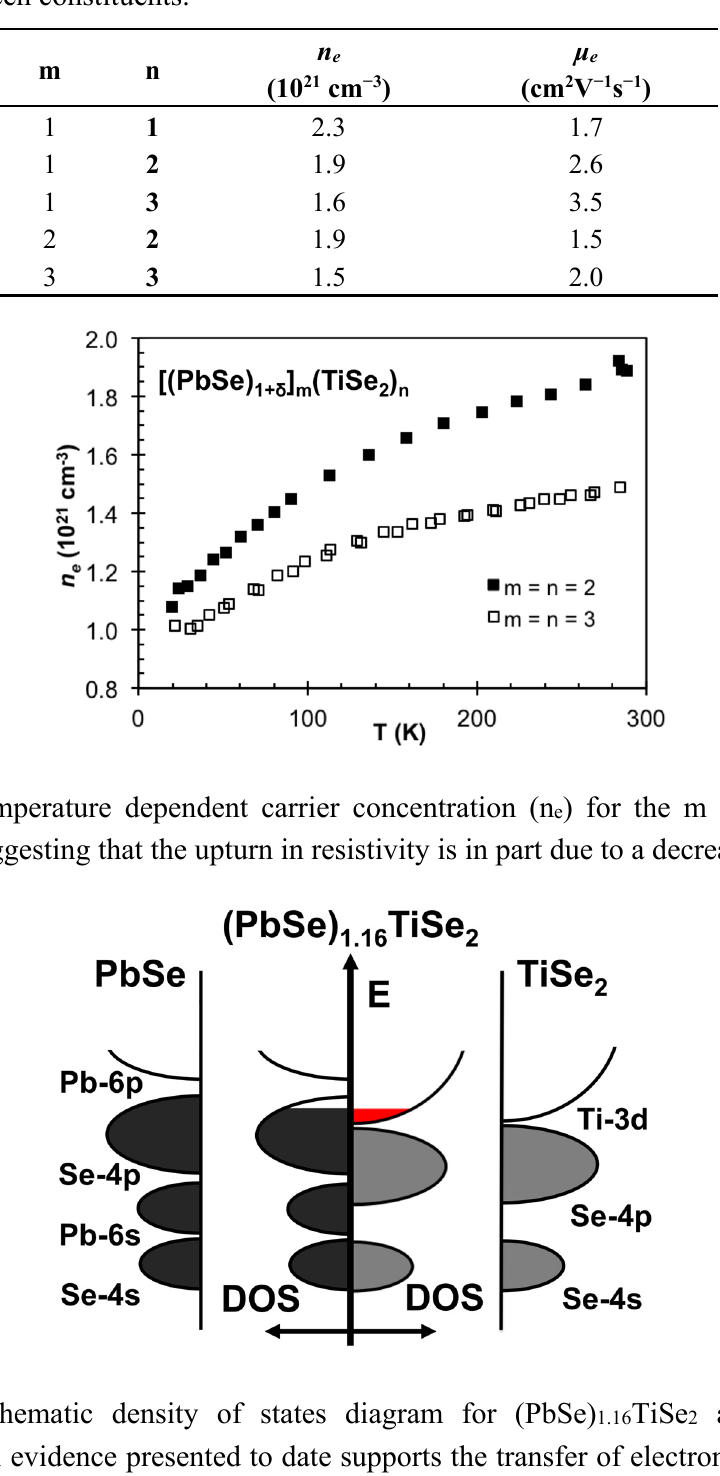
Table 2. Carrier concentration and mobility for compounds in set A. Carrier concentrations calculated from the Hall coefficient suggest that charge transfer is occurring between constituents.